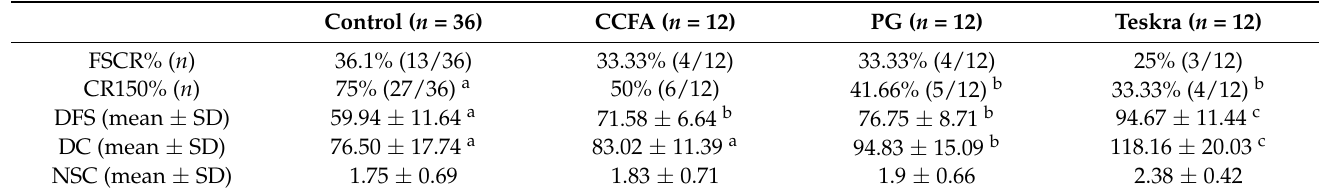
Table 3. Effect of treatment on reproductive parameters, days to first service interval, days to conception interval and number of services per